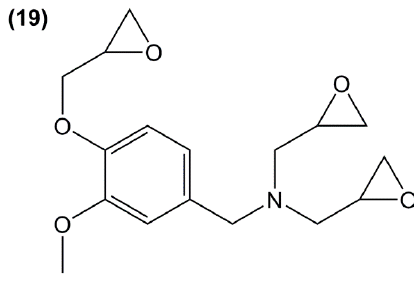
Figure 16. Aromatic derivatives with epoxy groups grafted on nitrogen atoms.